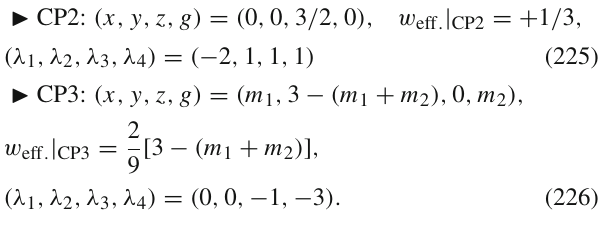
cates a physical saddle line. All the points on this line, have w eff . = 0. Since this line is thin, hence, schematically, three points have been put on it to make it visible. If we draw it thick, then we lose some vector fields which illustrate the saddle nature of this